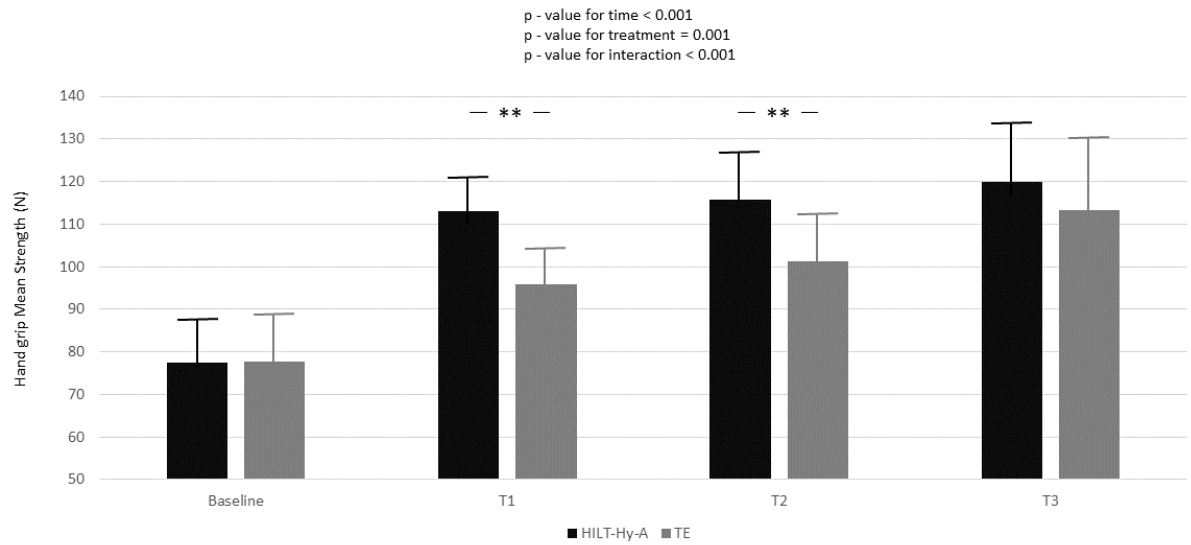
Figure 2. Handgrip mean strength variation according to time and treatment; black box represents high-intensity laser therapy plus hyaluronic acid (HILT+Hy-A) group, whereas grey box represents therapeutic exercise (TE). Results for the linear mixed model analysis ( p -values for time, treatment, and interaction for time for treatment). Bonferroni adjustment for multiple comparisons applied between follow-ups of the study compared to baseline; **: p <